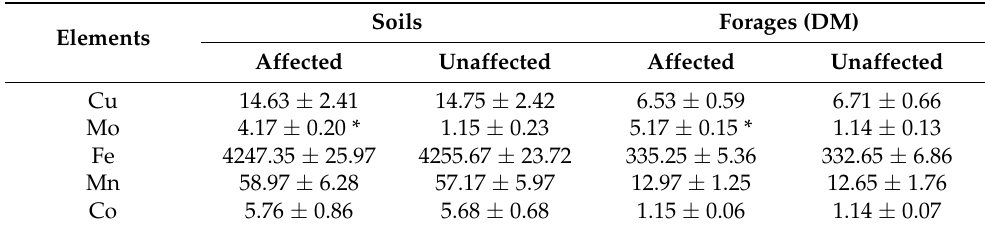
Table 1. The mineral nutrition in forage and soil ( µ g/g).